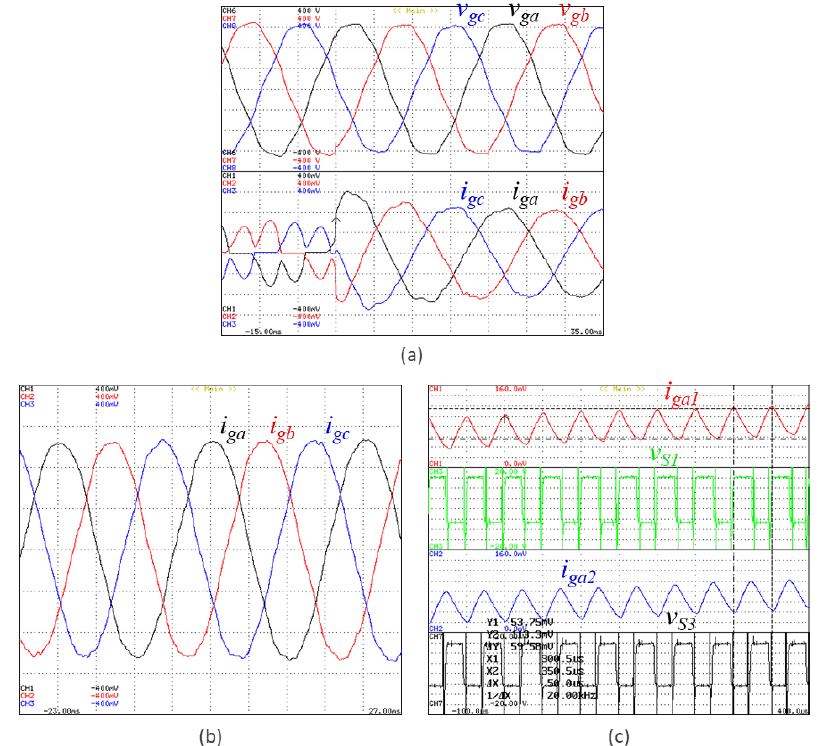
Figure 9. Experimental validation showing: ( a ) The currents of the AC-side interface before and after the controlled operation ( i UTa , i UTb , i UTc ); ( b ) The currents of the AC-side interface in steady-state ( i UTa , i UTb , i UTc ); ( c ) The currents of the AC-side interface ( i UTa , i UTa 1 , i UTa 2 ), for phase a , demonstrating the interleaved operation.